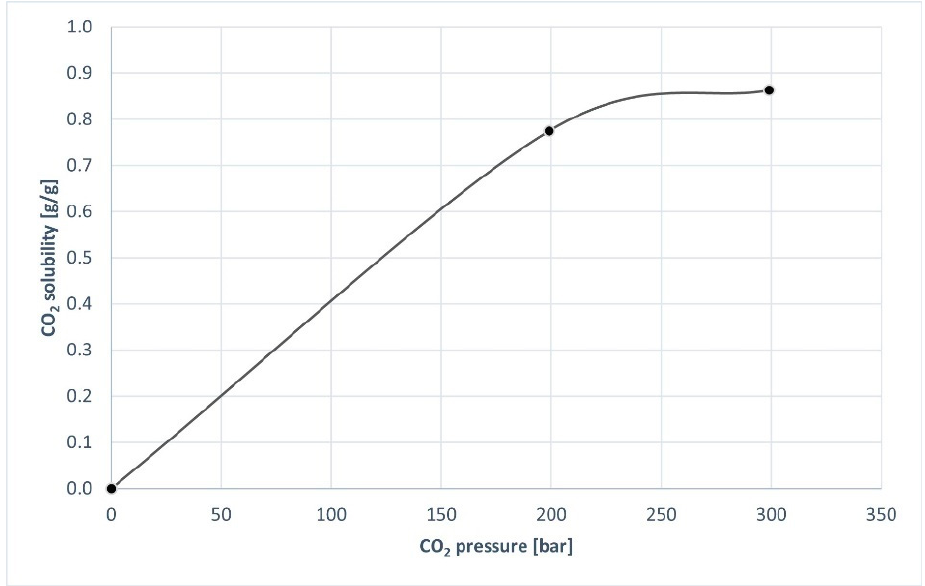
Figure 6. The solubility of CO 2 in spelt flour at 35 °C.